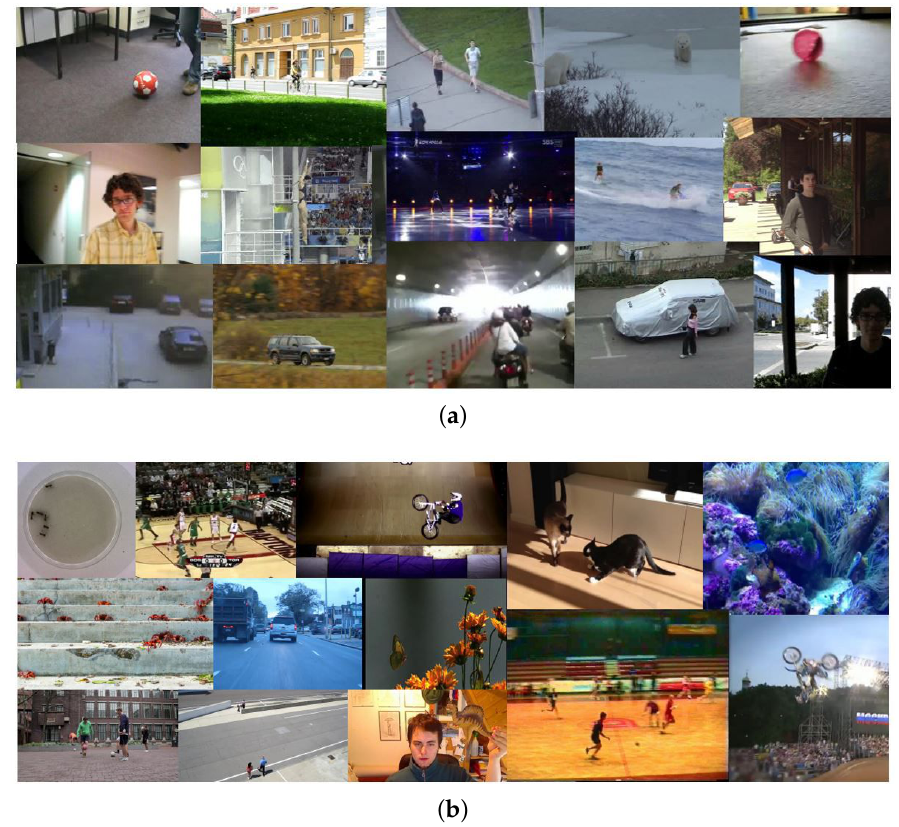
Figure 2. Samples from the Visual Object Tracking (VOT) 2014 ( a ) and 2018 ( b ) challenge datasets. The precision plots of VOT2014 and VOT2018 over the six subsequences are shown in Figure 3a,b, respectively. The x axis is the location error threshold, which is from 0.5 to 25 pixels with the pixel gap of 0.5, and the y axis is the average success frame rate of the algorithms over all the videos in the dataset. As shown in the graphs, the tracking precision between SiamFC and the proposed algorithm is almost the same. Tables 1 and 2 show the precision (with the local error threshold of 20 pixels), AUC, and IoU of VOT2014 and VOT2018 over the six subsequences, respectively. The results from Figure 3, Tables 1 and 2 indicate that extracting different scales of feature maps from the largest scale feature map insignificantly degenerates the tracking performance with respect to precision, AUC, and